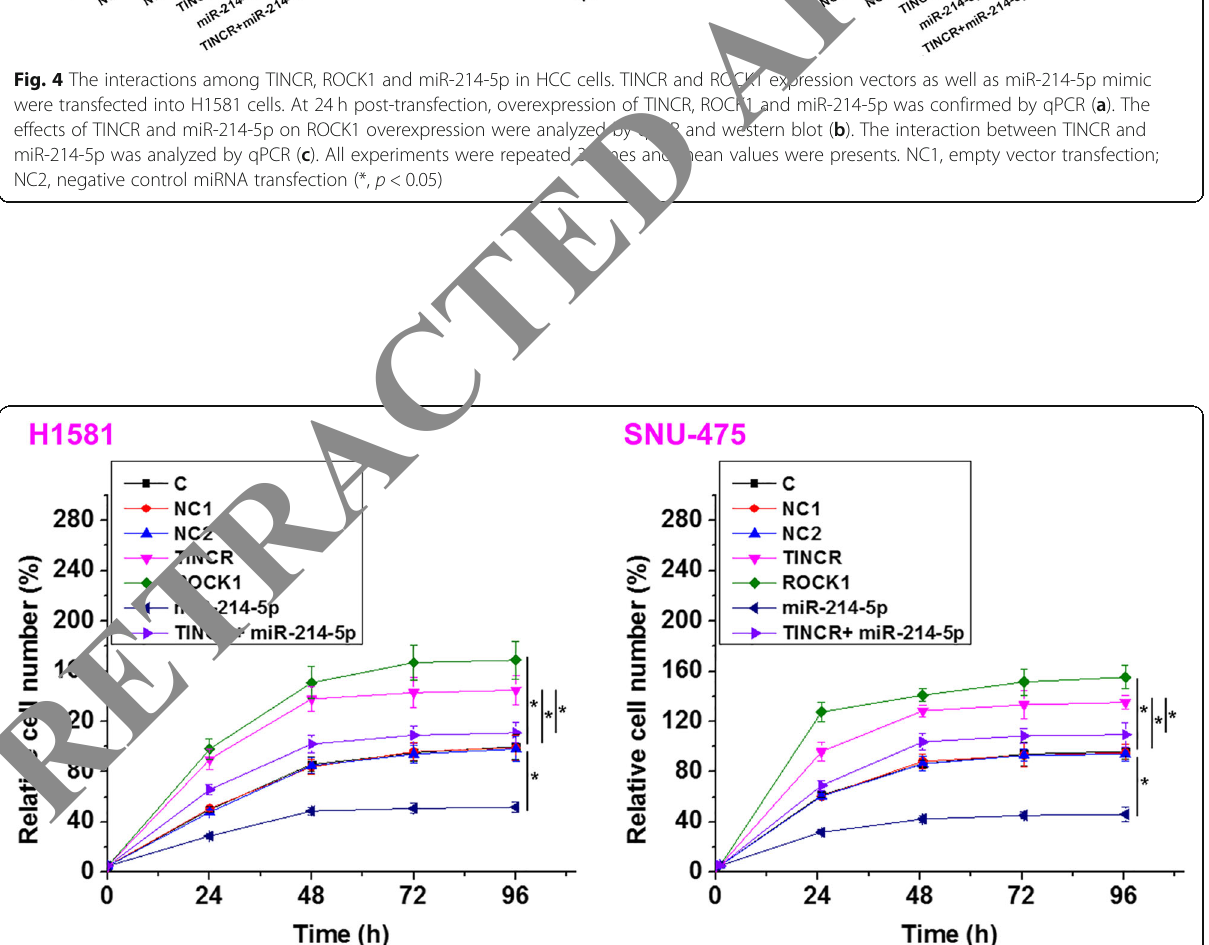
Fig. 5 TINCR promoted HCC cell proliferation through ROCK1 and miR-214-5p. The effects of TINCR, ROCK1 and miR-214-5p on HCC cell proliferation were analyzed by cell proliferation assay. All experiments were repeated 3 times and mean values were presents. NC1, empty vector transfection; NC2, negative control miRNA transfection (*, p <